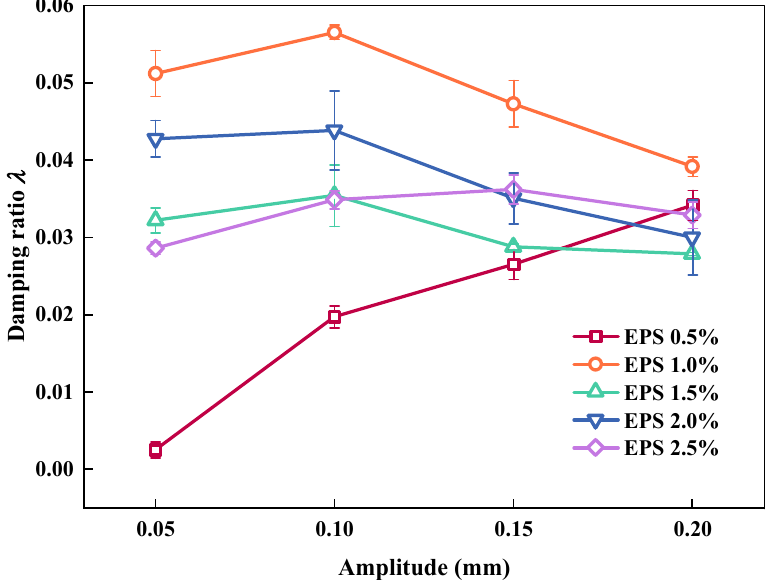
Figure 13. Relationship between amplitude and λ .